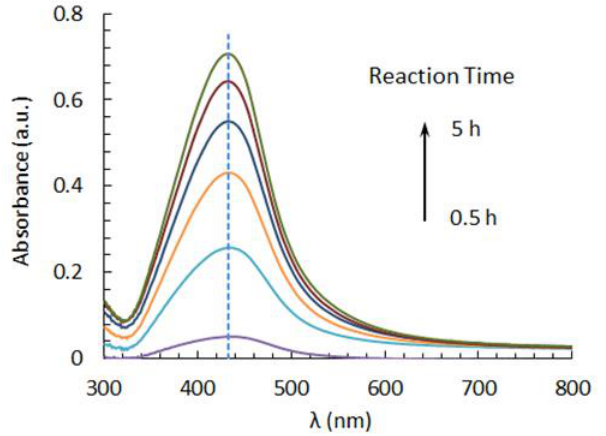
Figure 2. Evolution of the SPR band of AgNPs at 40 °C and pH 11 in reaction media containing silver nitrate and SCG extracts.